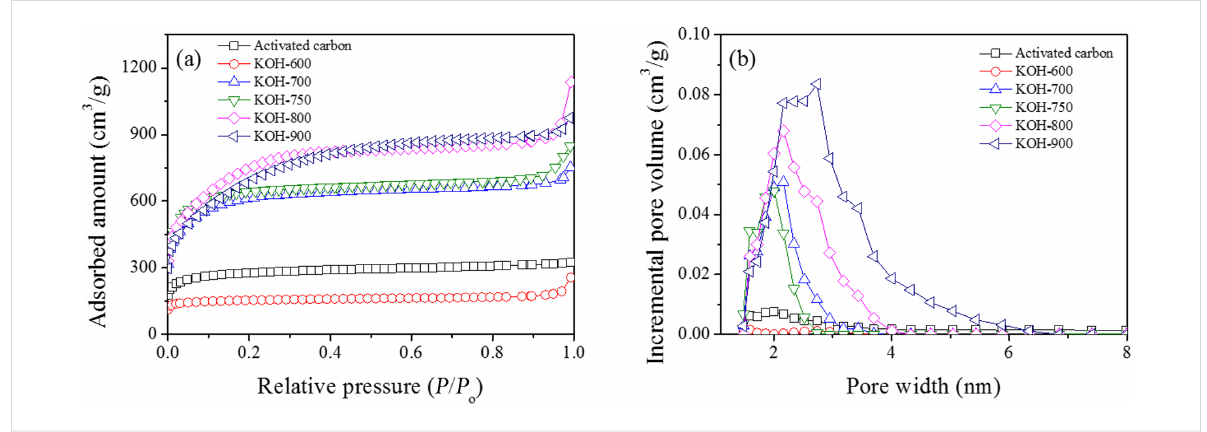
Figure 1: (a) N 2 adsorption isotherms and (b) pore size distribution of PDC materials and activated carbon (AC) .